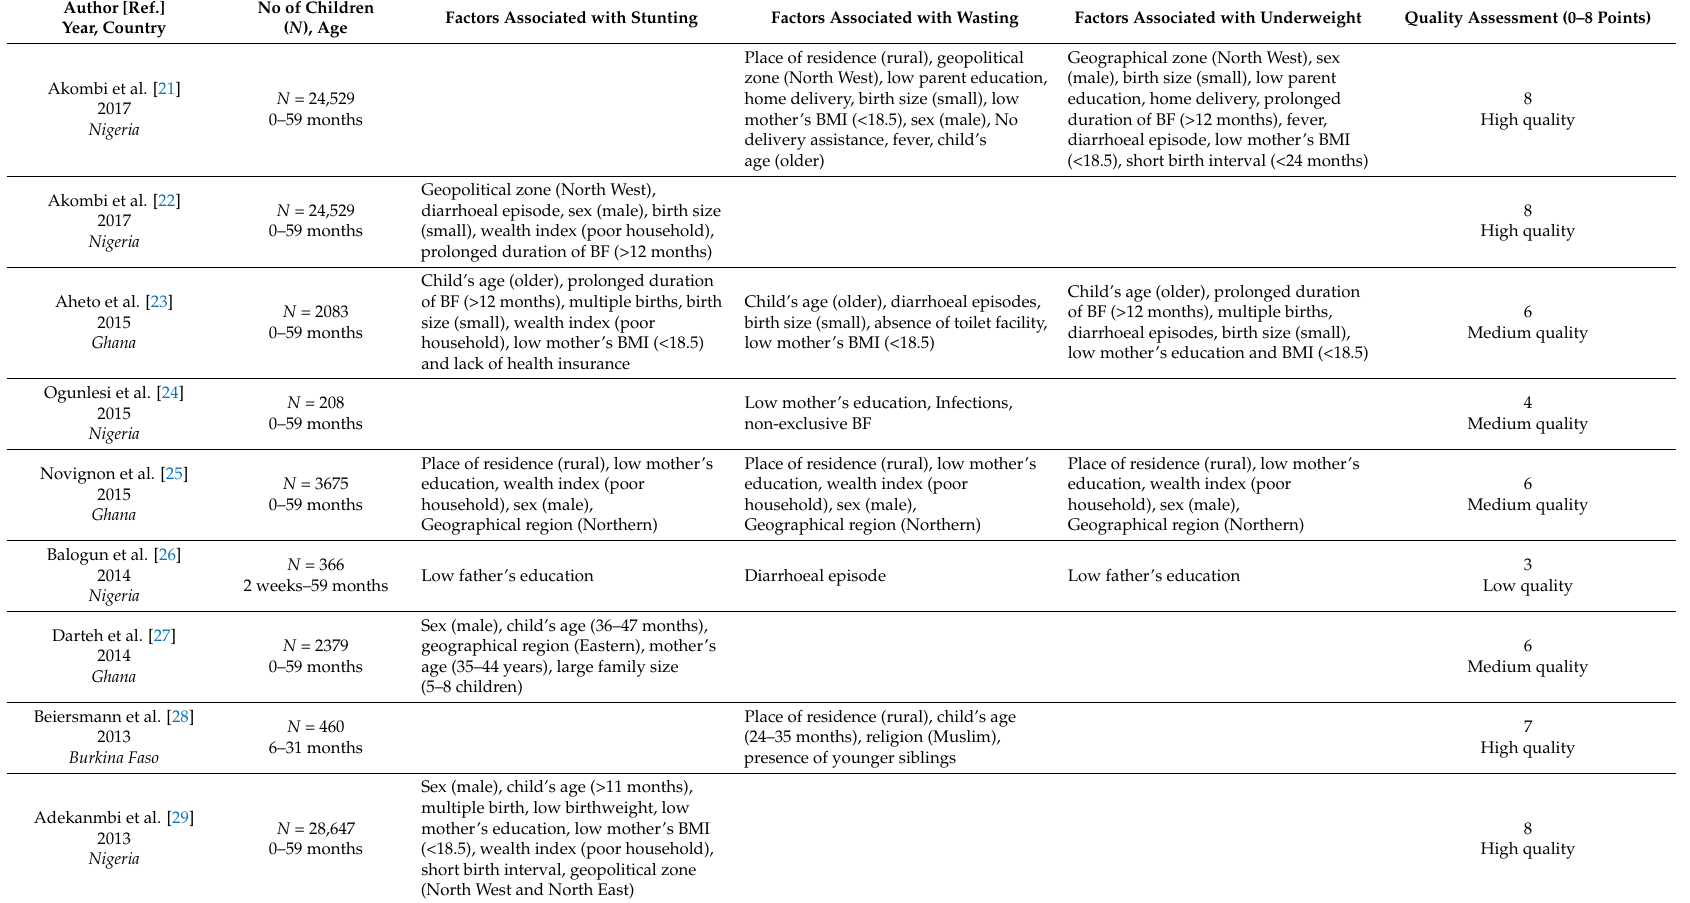
Table 1. Summary of selected